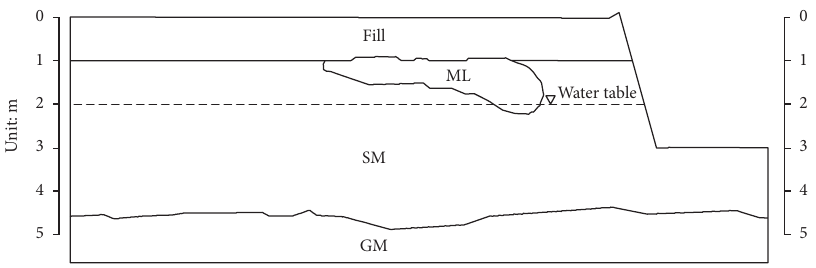
Figure 15: The soil profile of the Chi-Chi case developed by Chu et al. [40]. Table 9: Soil parameters used for nonlinear effective analysis.